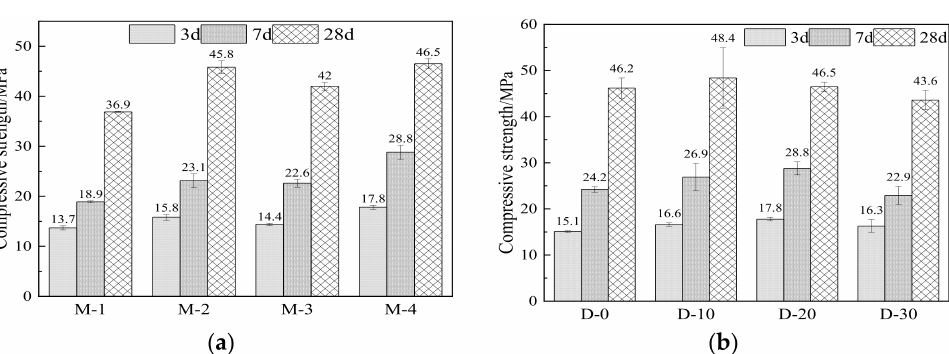
Figure 3. Compressive strength tests. ( a ) The coupling effect of a ternary system, ( b ) replacement ratios of the composite